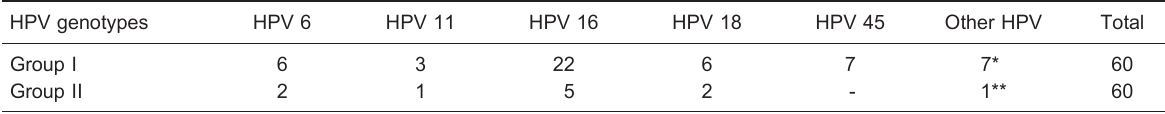
Table 3. Frequency of HPV genotypes detected by PCR and RFLP in samples of female patients from groups I (CIN) and II (asymptomatic). HPV